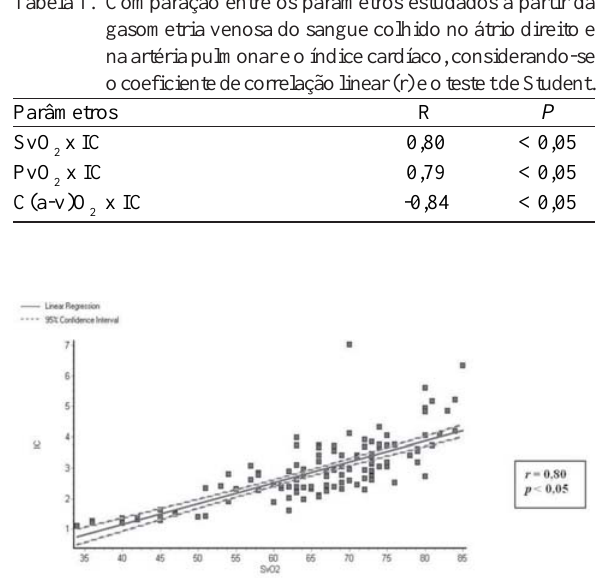
Fig. 1 - Correlação entre saturação de oxigênio do sangue do átrio direito (SvO ) e índice cardíaco (IC) 2